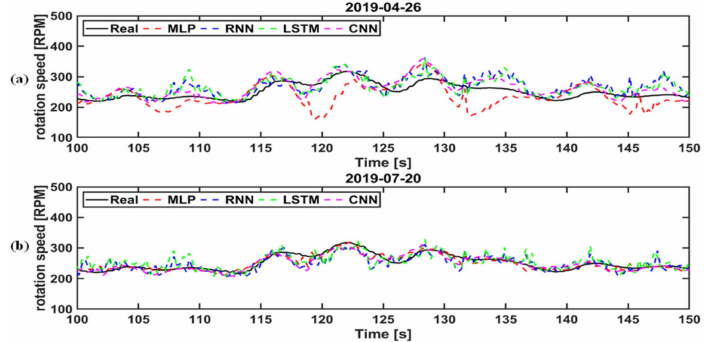
Figure 17. Detailed comparison of the prediction performances of each algorithm for the conditions of Cases 3 and 4. Prediction result of test dataset 16 August 2019 using ( a ) the 26 April 2019 training dataset and ( b ) the 20 July 2019 training